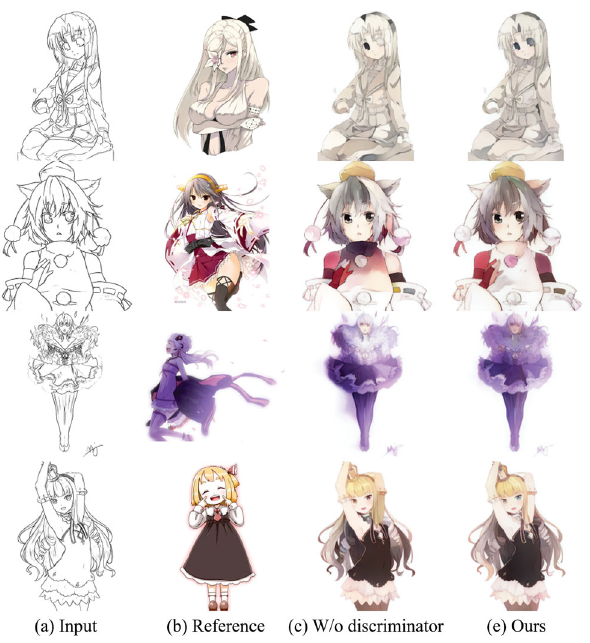
Fig. 8 Comparison: with and without the discriminator.